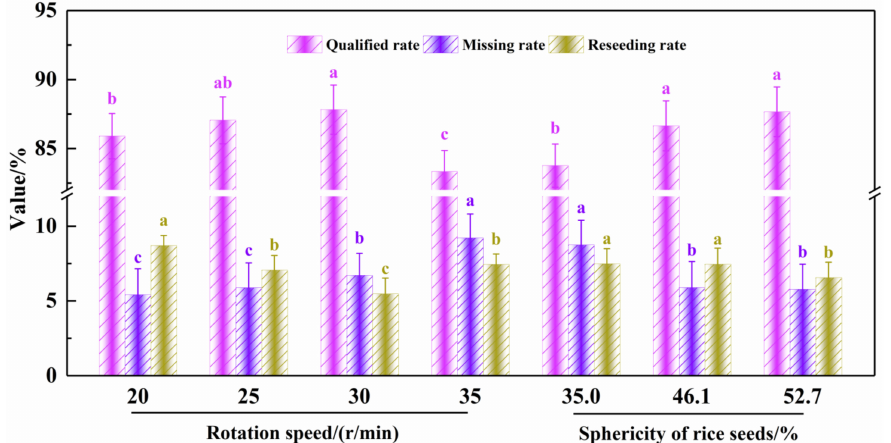
Figure 9. The influence of factor levels on experiment indexes. Groups with the same letters of a, b, c were considered to be not significantly different, and data without the same letters of a, b, c were considered to be significantly